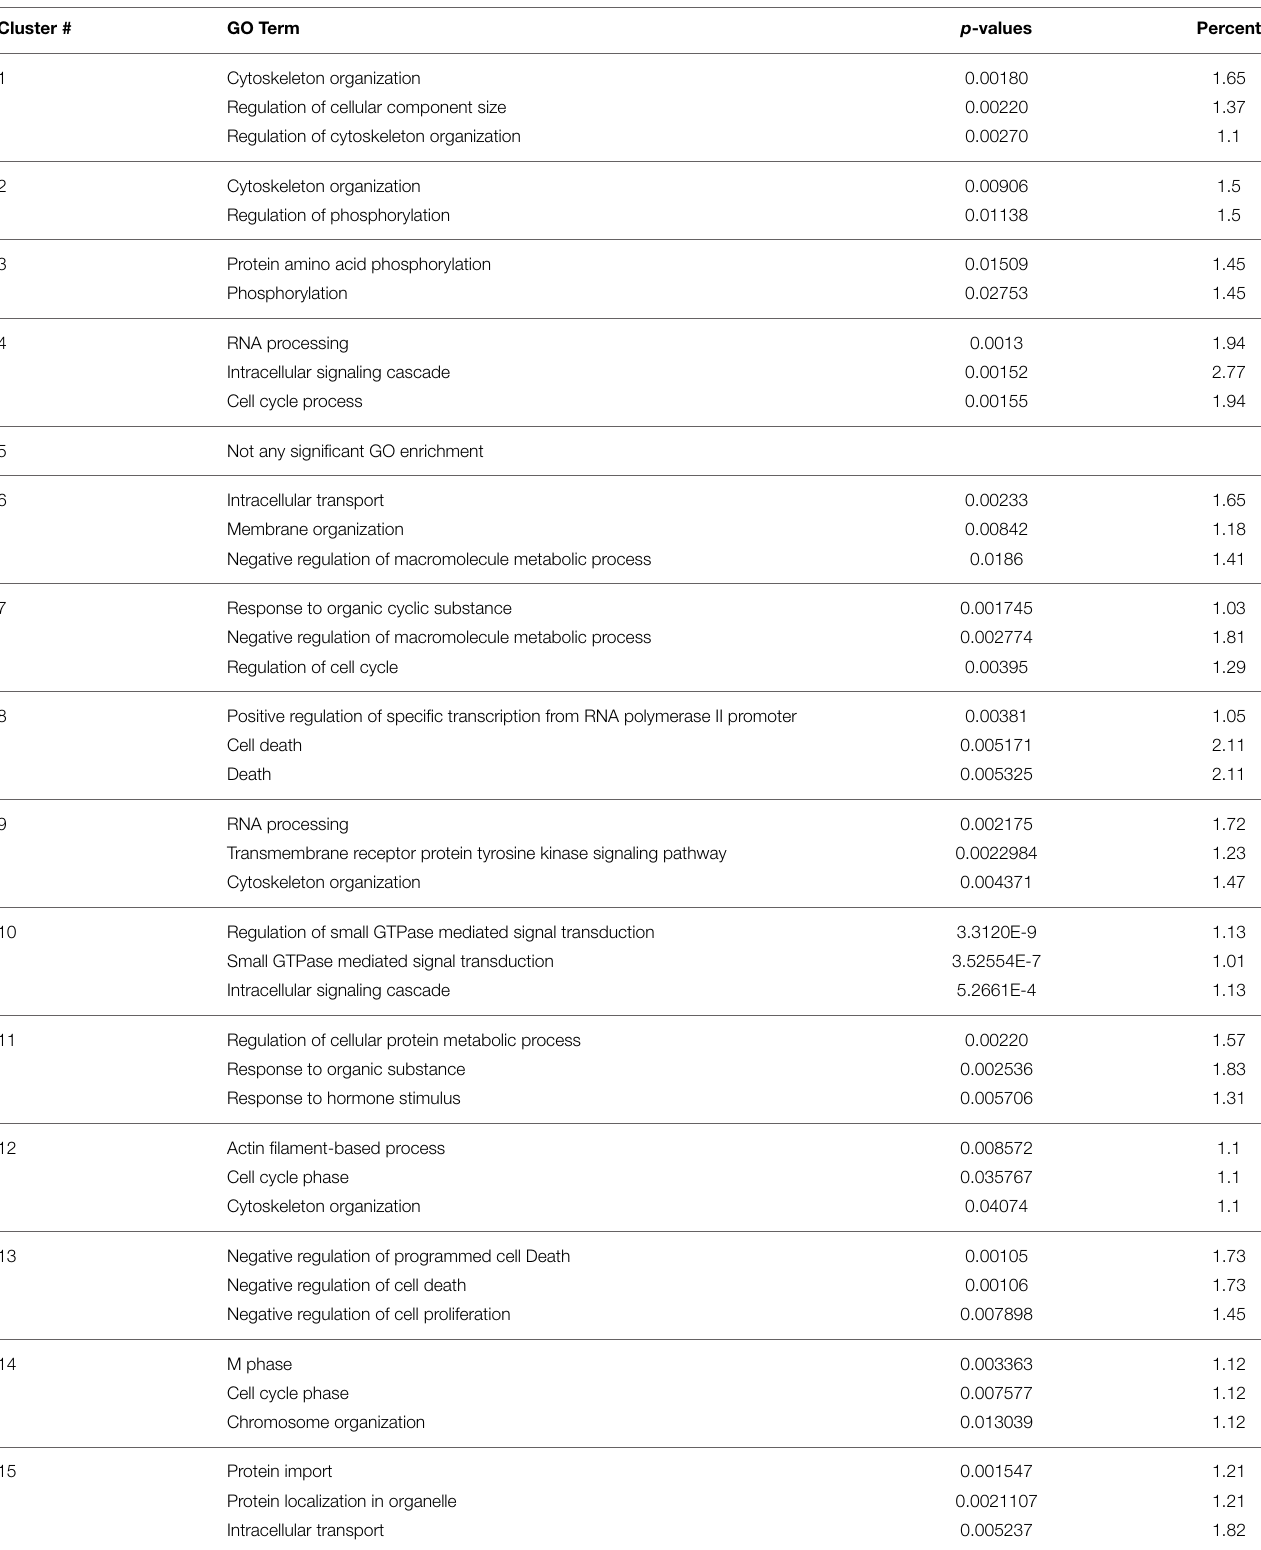
TABLE 2 | Gene ontology (GO) biological process enrichments of each cluster located in the final network. Cluster